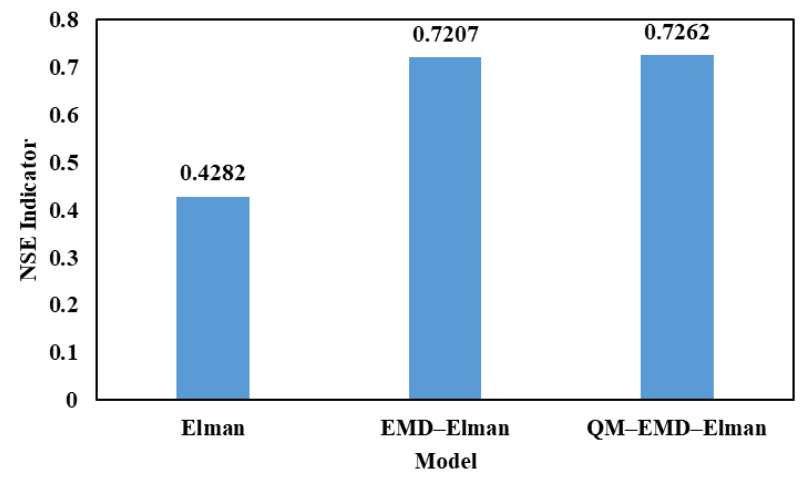
Figure 11. Scatter fit plots of the predictive value of two models.